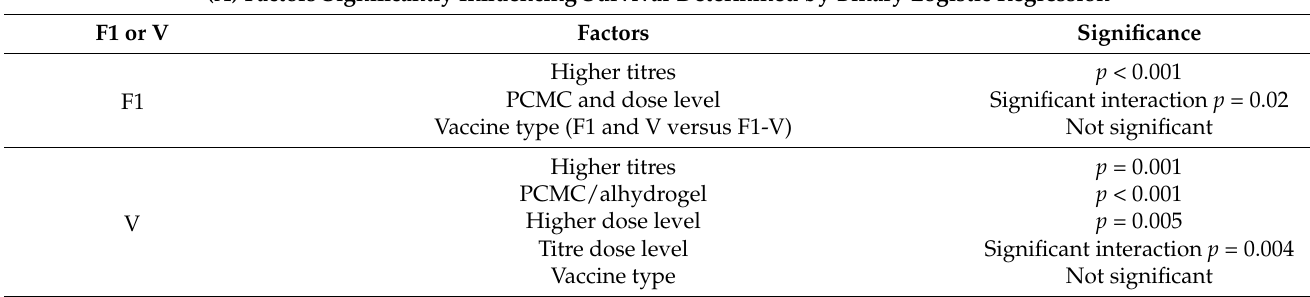
Table 3. Summary of the results of statistical